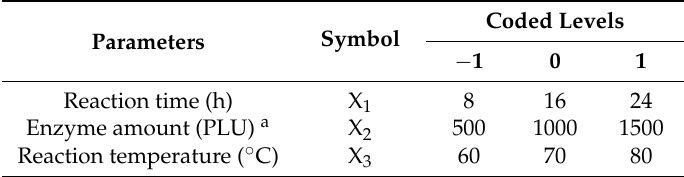
Table 5. Coding of experimental parameters and related levels.